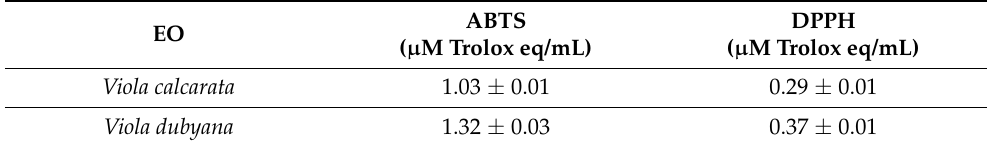
Table 2. Antiradical power of EOs from Viola dubyana and Viola calcarata . ABTS EO ( µ M Trolox eq/mL)